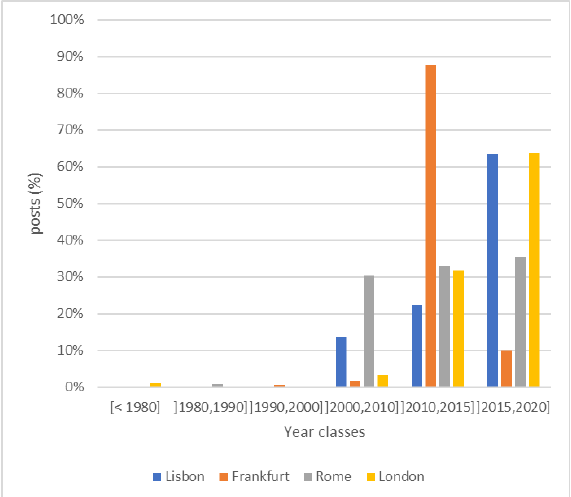
Figure 2. Temporal distribution of posts by city, with posts being grouped by classes of years